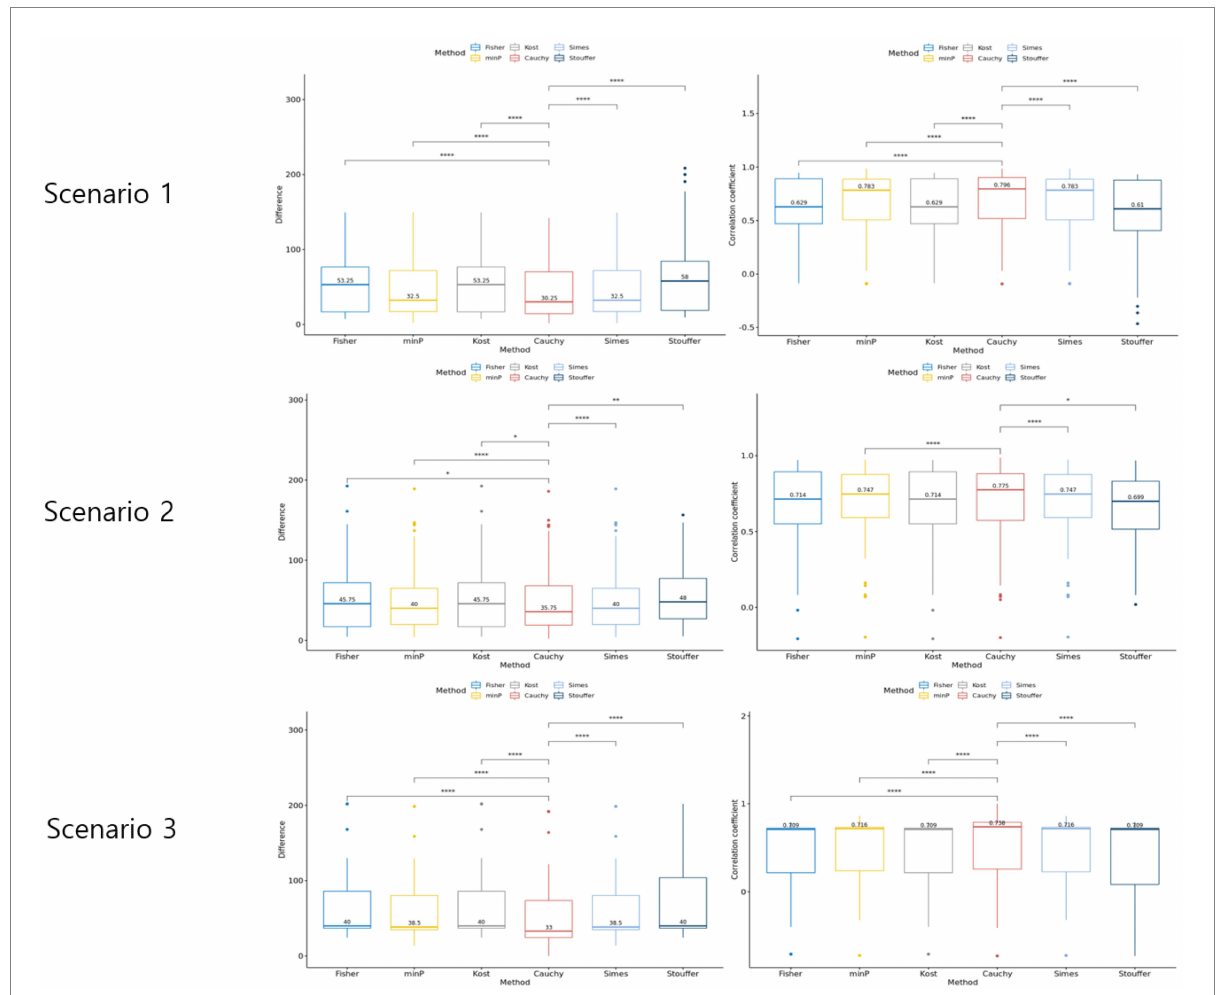
FIGURE 4 Results of the simulation setting 2. The graphs in the left column represent rank difference of each value of p combination method. The graphs in the right column represent the Spearman rank correlation of each p -value combination